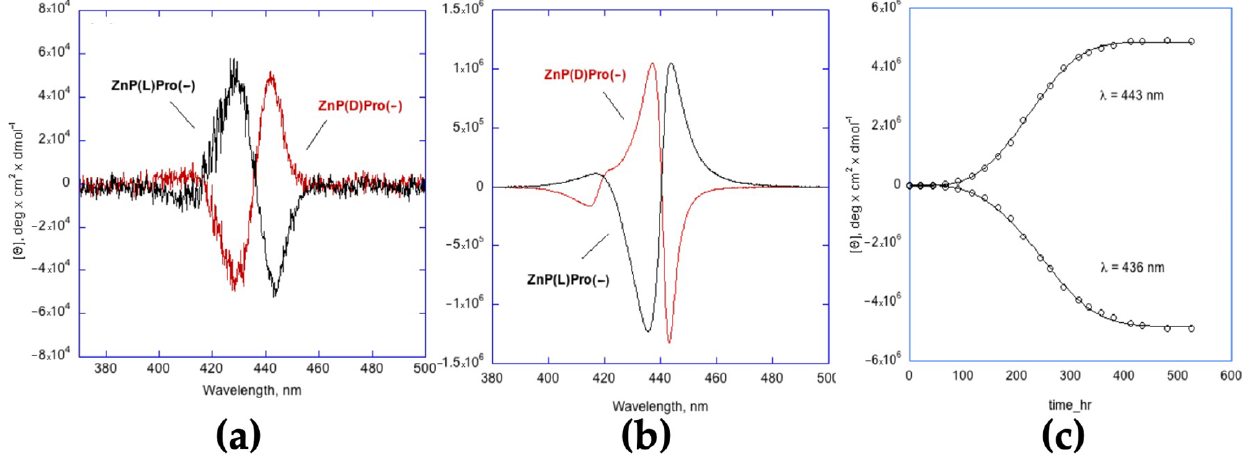
Figure 5. Aggregation of ZnP(L)Pro( − ) and ZnP(D)Pro( − ) (5 µ M; EtOH/H 2 O 25/75 v:v). ( a ) CD plot at the initial (t = 0) stage; ( b ) CD plot at equilibrium. ( c ) Autocatalytic kinetic profile for the second stage of the aggregation of the (L)-derivative. The points represent the variation of the CD bands vs. time at the given wavelength. Adapted from OPEN ACCESS [44].